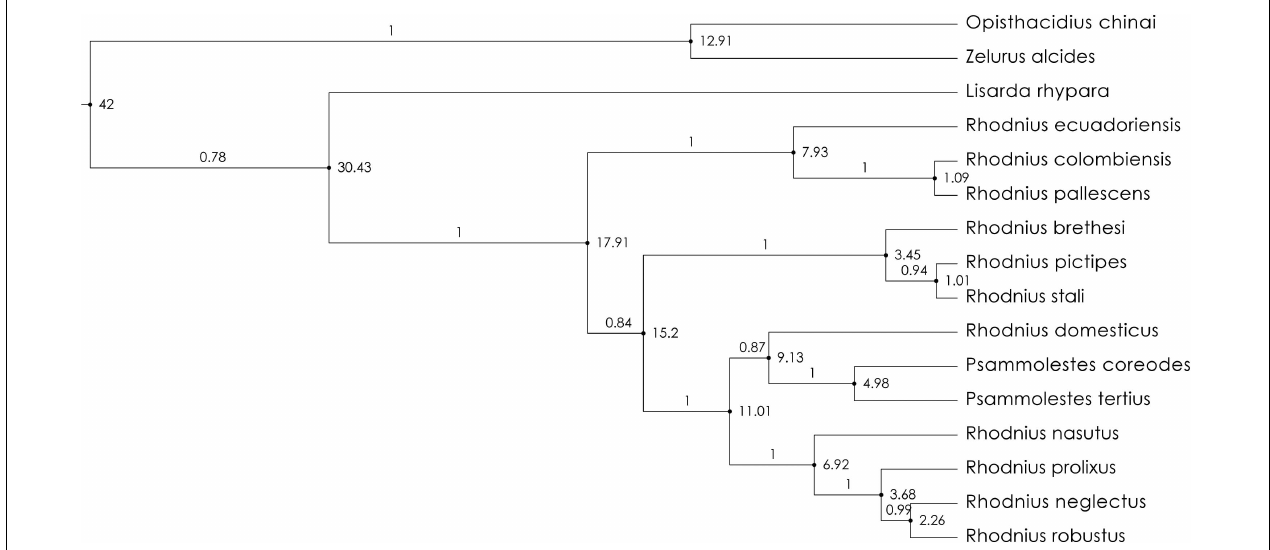
FIGURE 3 | Molecular clock analyses (B EAST 2.6.2) combining the 16S + 28S + wingless sequences, and using gamma model, generalized time reversible (GTR), and lognormal relaxed clock. The values in the nodes represents time in millions of years ago (Mya). The values above the branches are posterior probability.